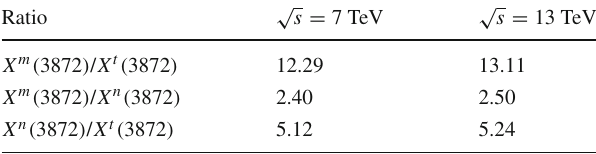
Table 3 The yield ratio of X ( 3872 ) of different structures produced in √ pp collision at s = 7 and 13